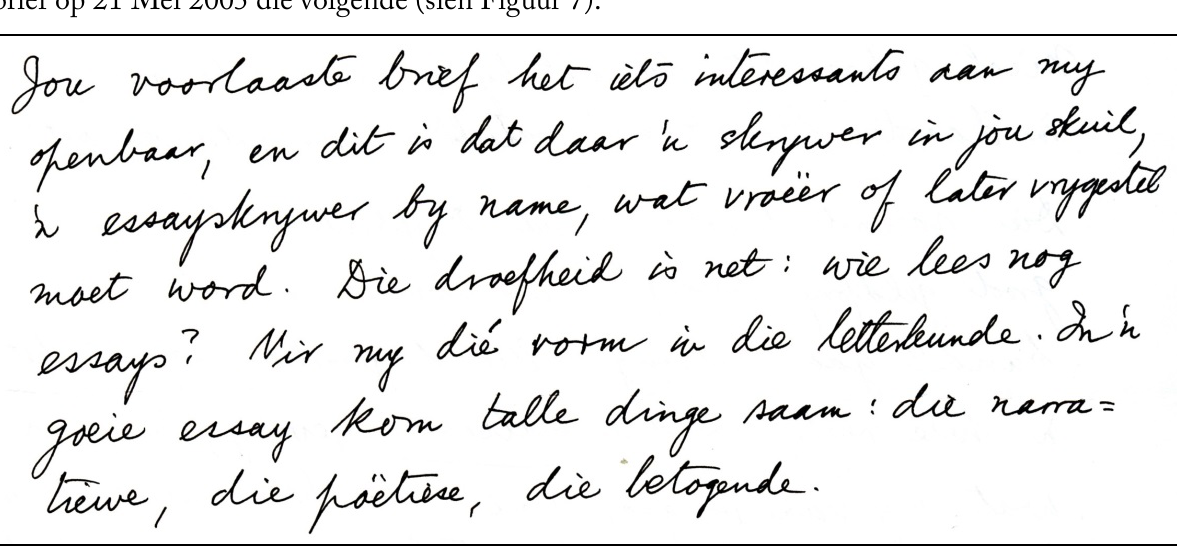
TD, 10(1), July 2014, pp. 123- 148. 137